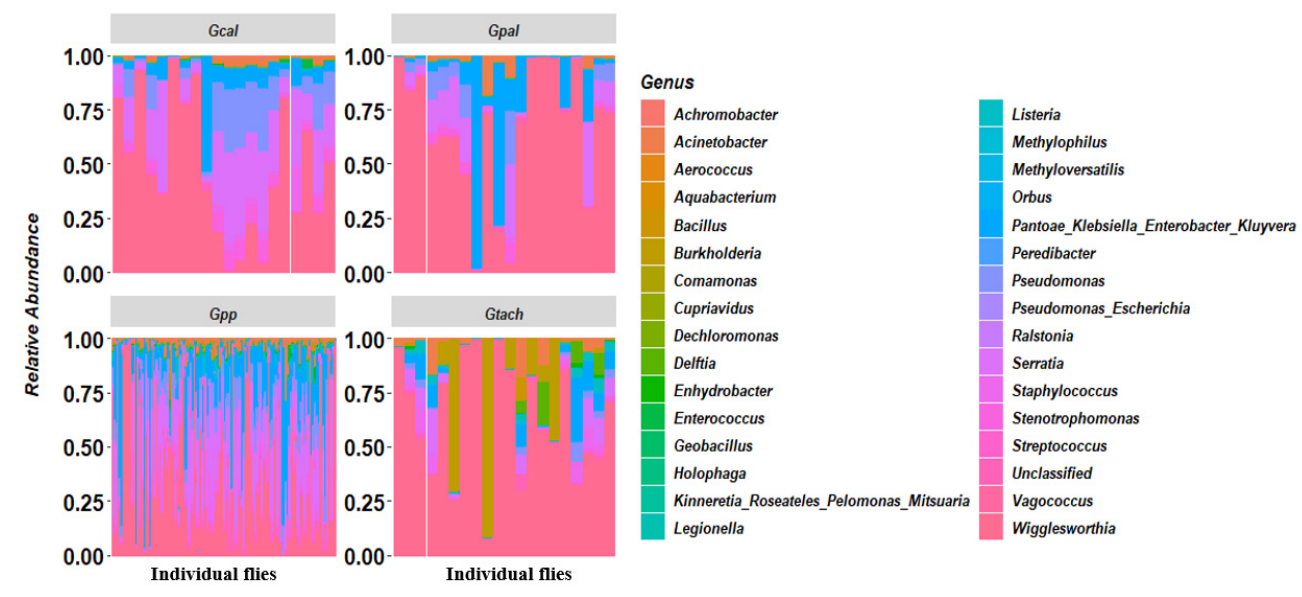
Figure 3. Map showing the relative abundance and distribution of the bacterial genera within different tsetse species ( Gtach : Glossina tachinoides ; Gpp : G. palpalis palpalis ; Gcal : G. caliginea ; Gpal : G. pallicera ).